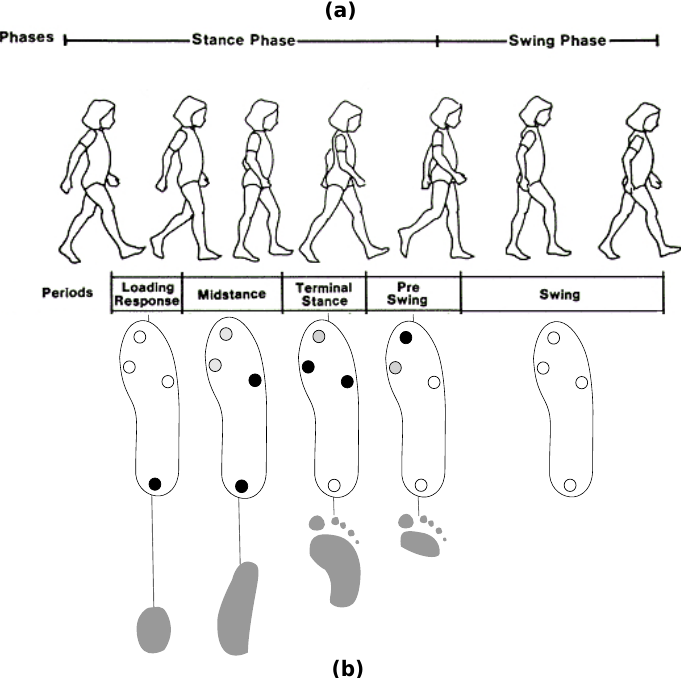
Figure 3. Detected gait subphases ( a ). FSR and foot pressure patterns ( b